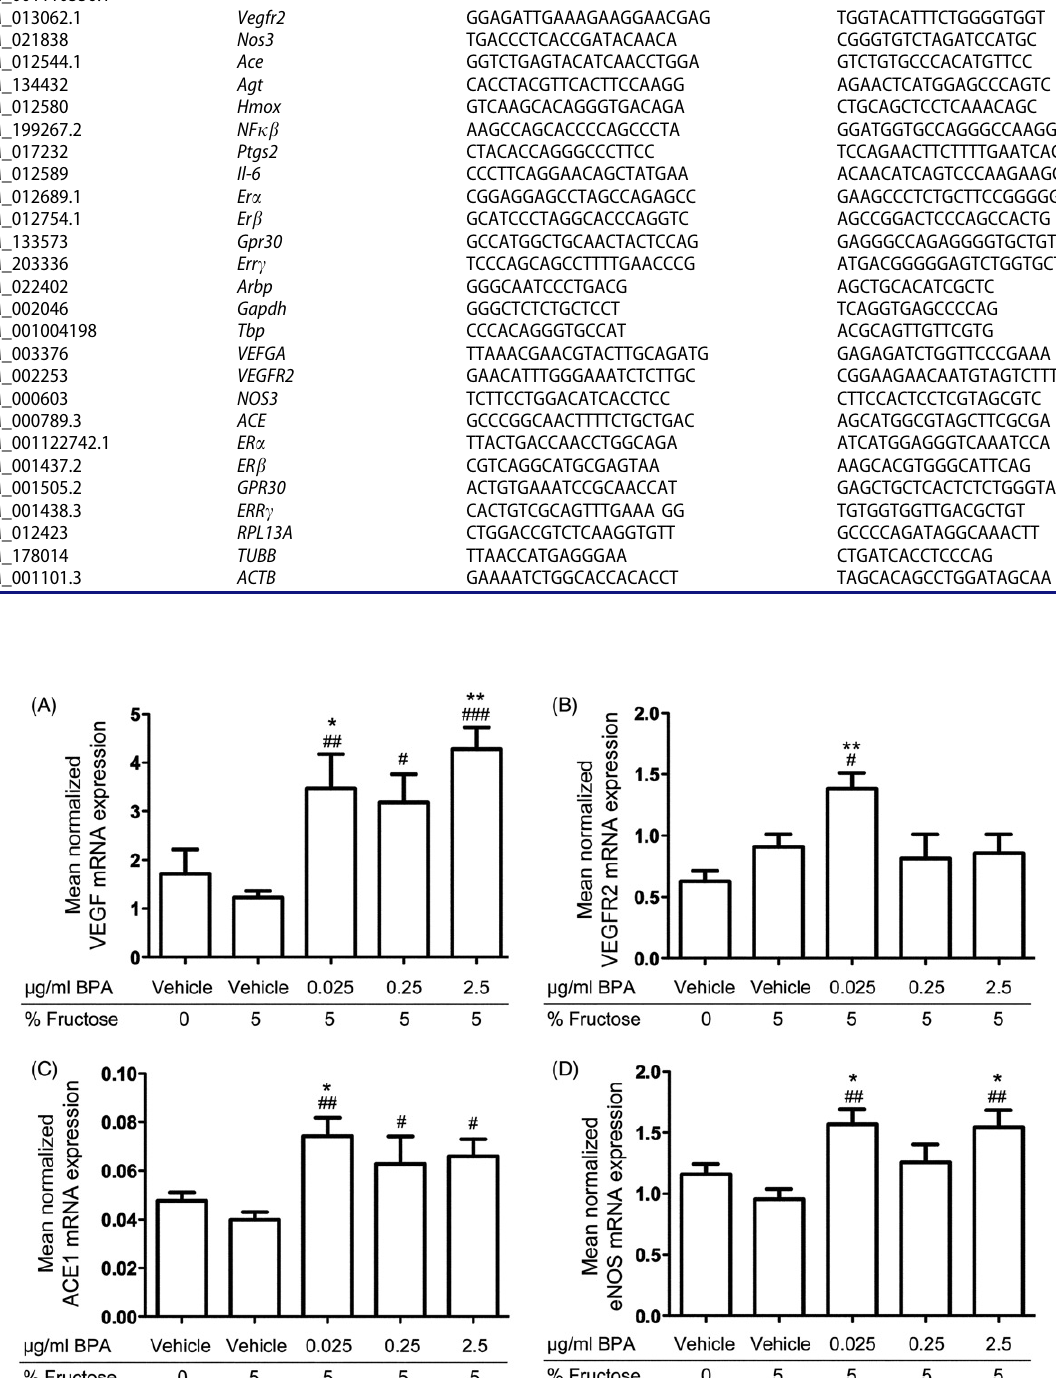
(cid:5) (cid:5)(cid:5) P < .05, P < .01,